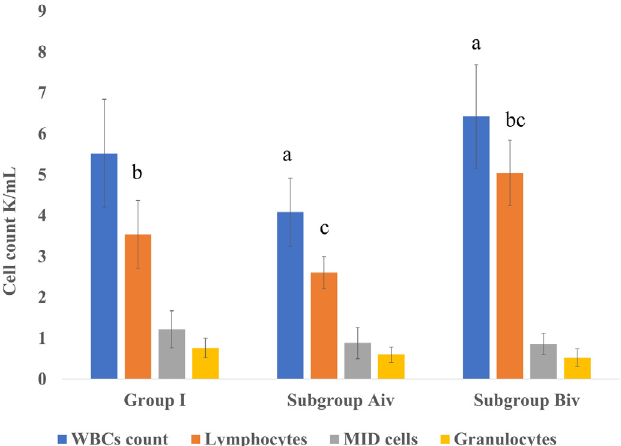
Fig. 8. A chart shows WBCs count results (mean ±standard deviation) of subgroups treated with 7,12-dimethylbenza[a]anthracene (DMBA) for 6 weeks then, Nigella Sativa (Aiv) or Thymoquinone (Biv) for 6 weeks in comparison to each other and to healthy untreated group (GI). MID: Less frequently occurring cells such monocytes, eosino- phils, basophils and other precursor white cells. abc Indicate that a signi fi cant difference ( P value < 0.05) exists between compared sub/ groups that are marked with the same